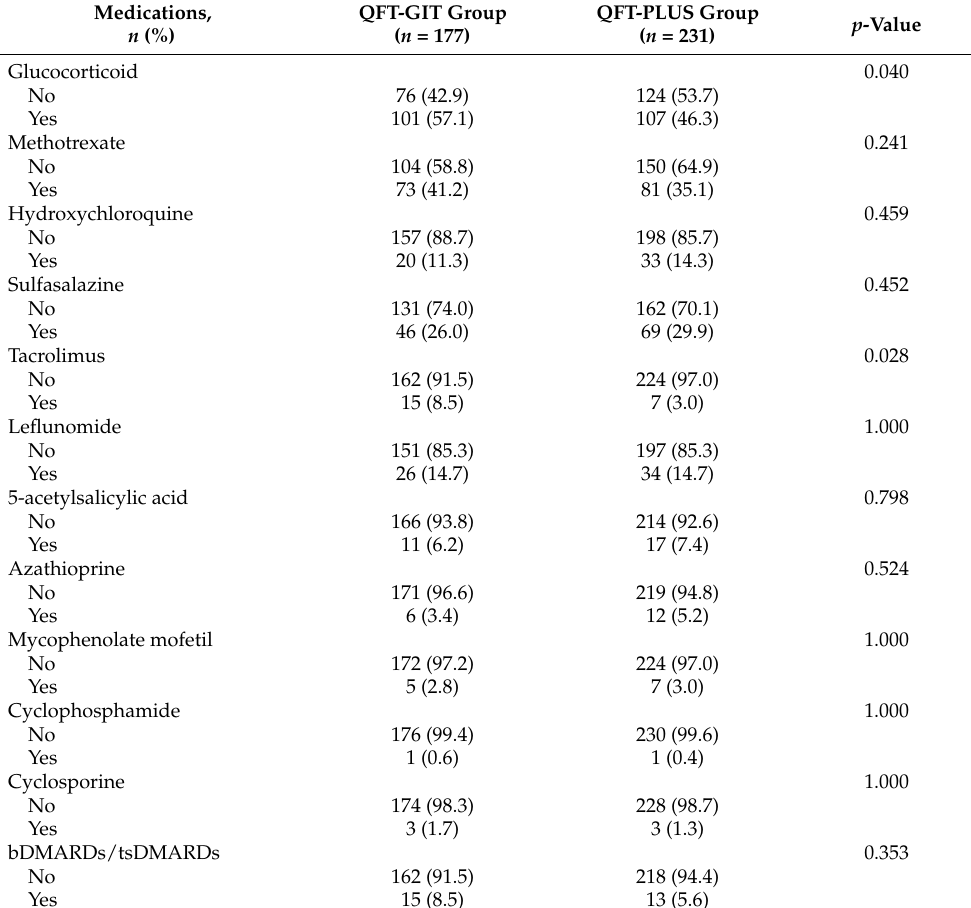
QFT-GIT Group ( n = 177)